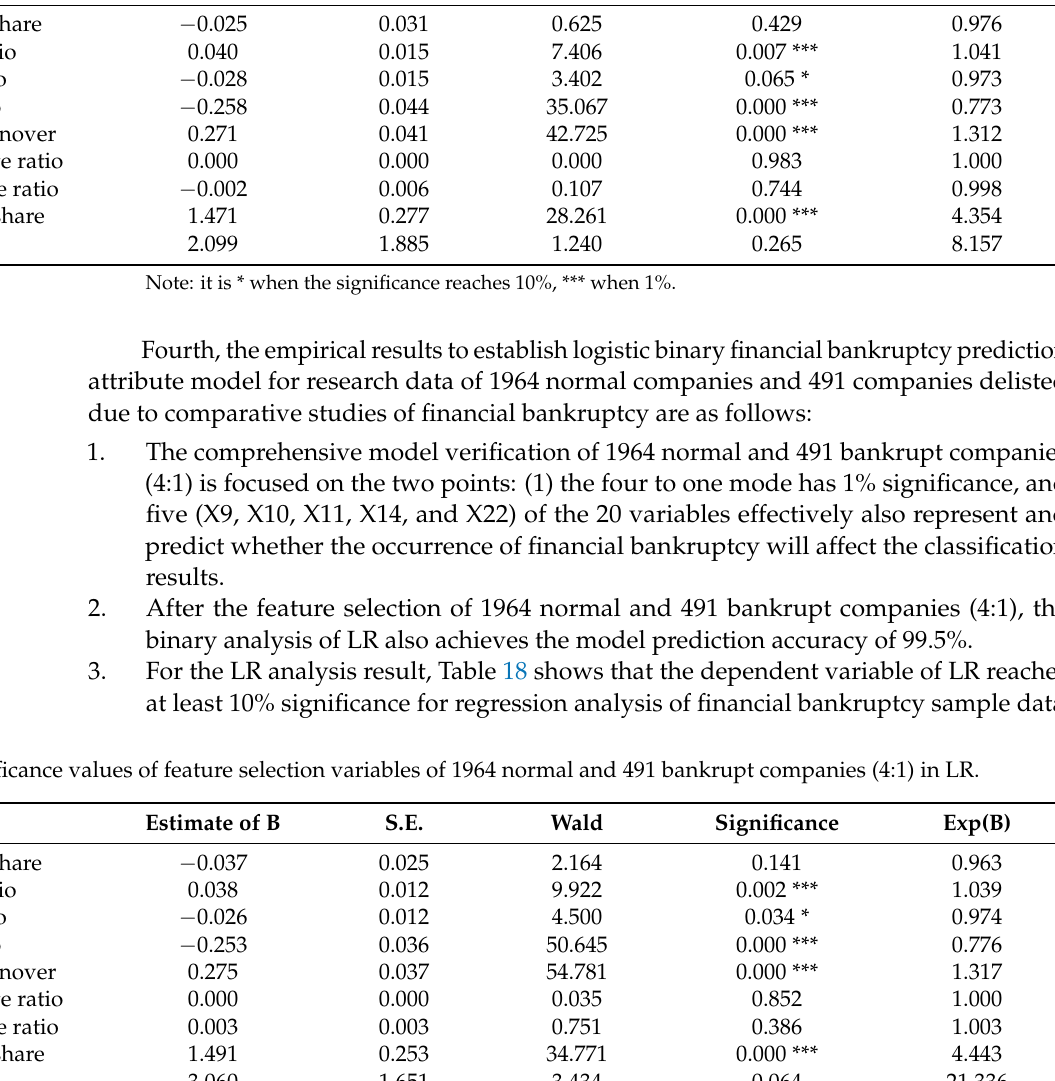
Table 17. Significance values of feature selection variables of 1473 normal and 491 bankrupt companies (3:1) in LR. Variables